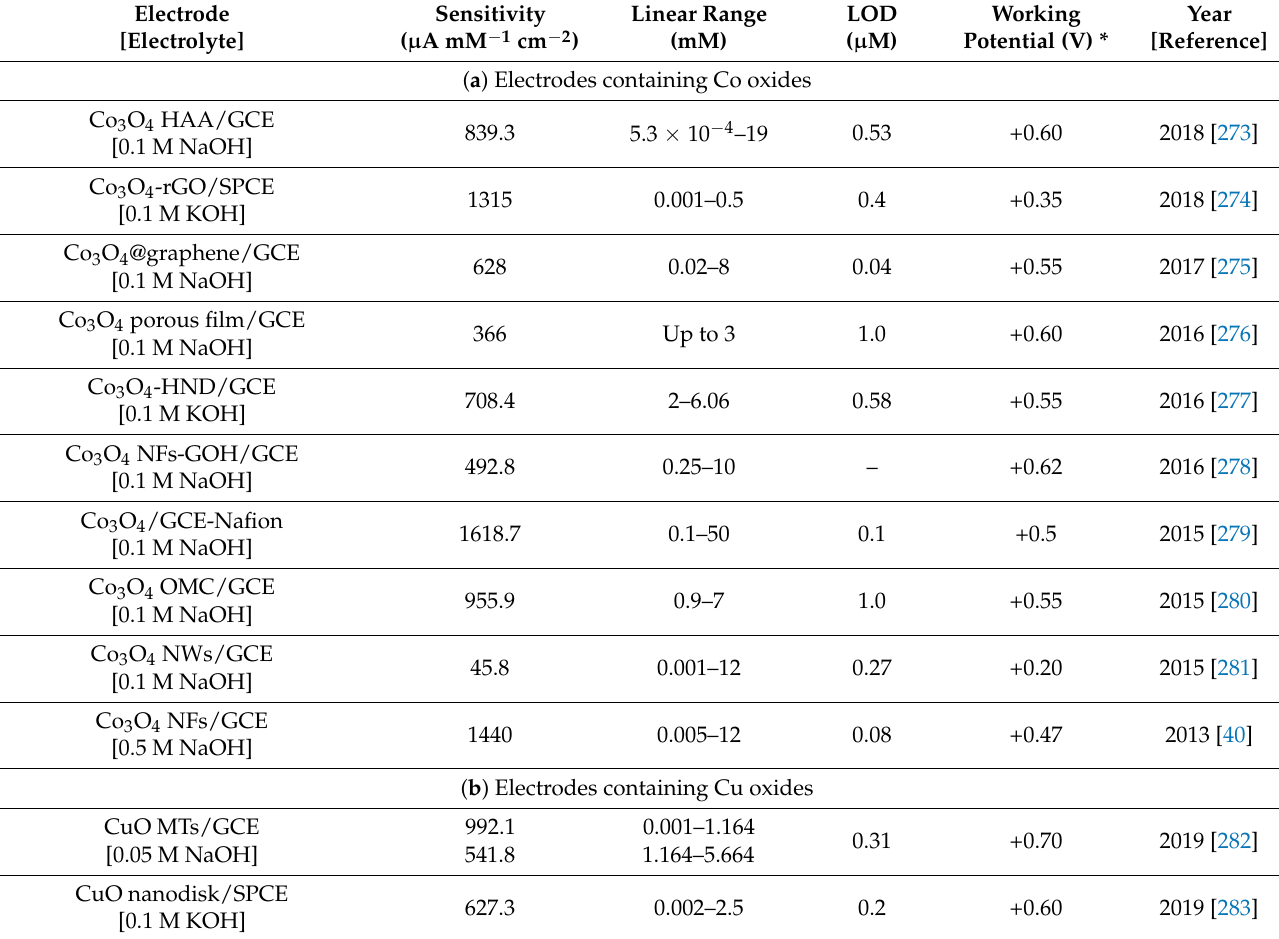
Table 5. The electrodes for the sensing of glucose by the transition metal oxides of ( a ) Co, ( b ) Cu, and ( c ) Ni materials within this decade. The performances are compared in terms of sensitivity, linear range, limit of detection (LOD), and working potential. The working potentials are based on the reference electrode of